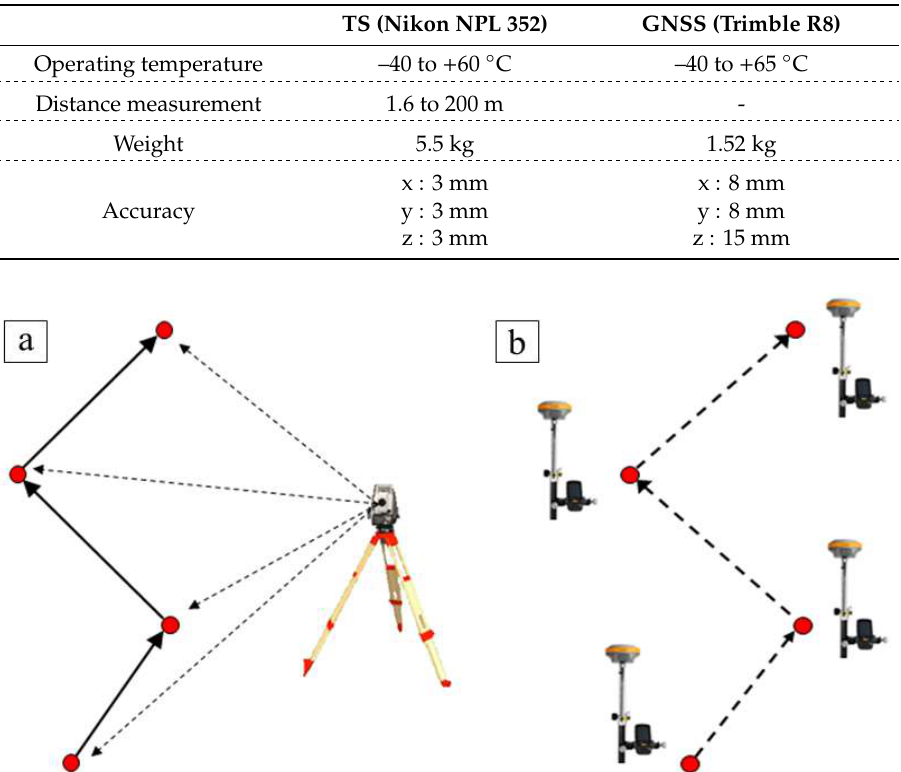
Figure 4. Schematic diagram displaying the difference between ( a ) Total Station (TS) survey with relative coordinates) and ( b ) Global Navigation Satellite System (GNSS) survey with absolute coordinates. Table 3. Specifications of Total Station (TS) [28] and Global Navigation Satellite System (GNSS) [27].